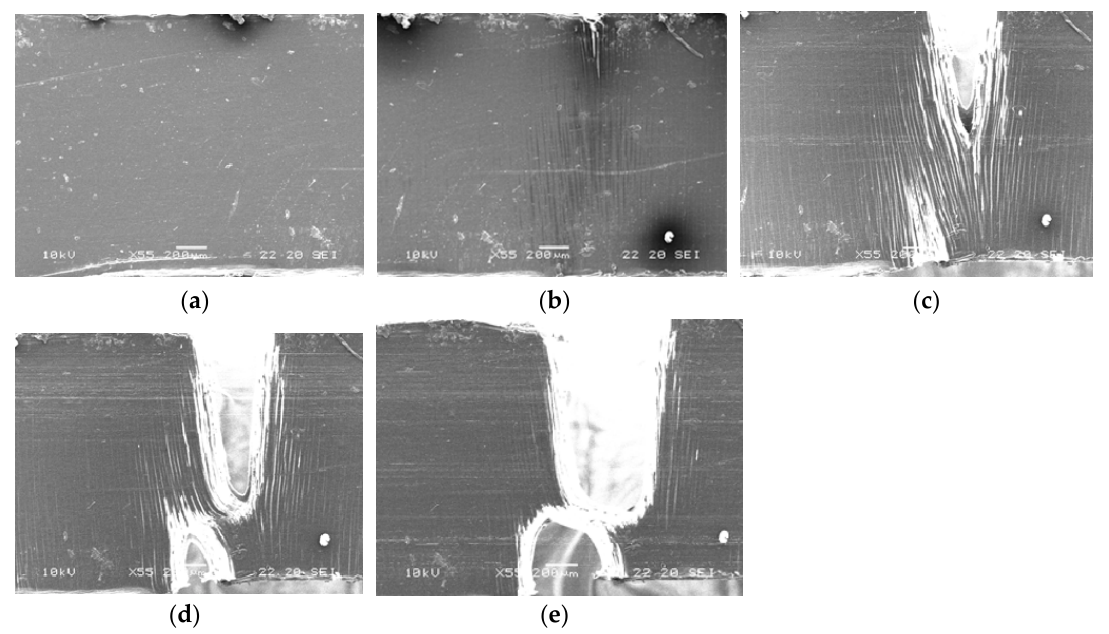
Figure 8. In situ SEM micrographs of the structure evolution of the in situ generated PLA/PHA composite subjected to a tensile test. The respective deformations are ( a ) 0.020, ( b ) 0.077, ( c ) 0.166, ( d ) 0.223, and ( e ) 0.247.